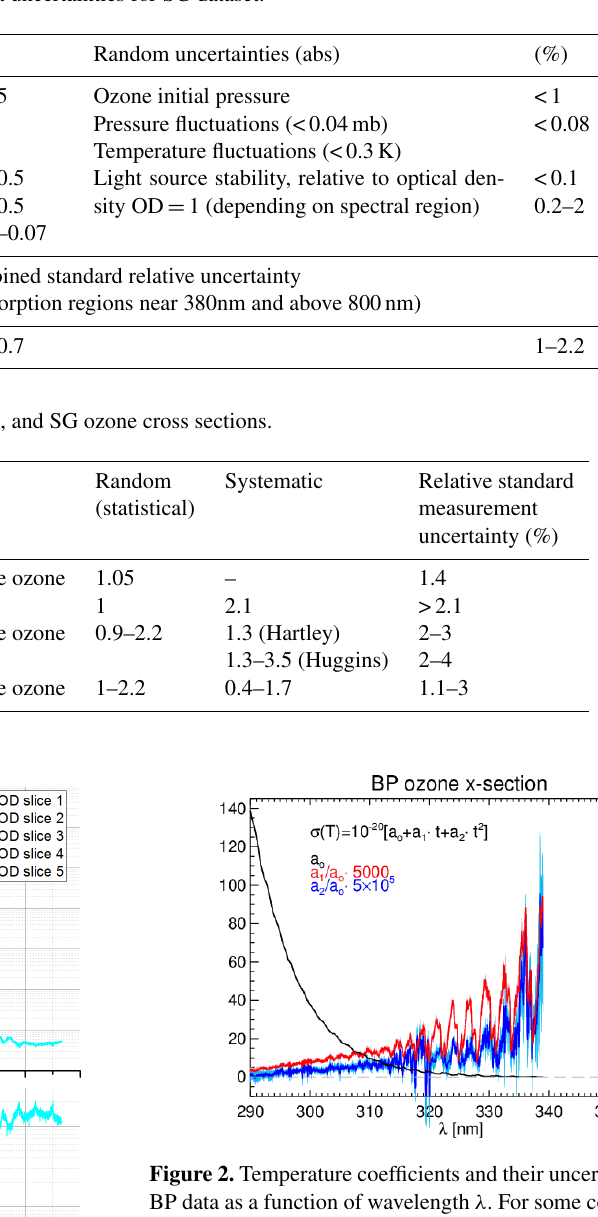
Table 5. Summary of absolute and relative measurement uncertainties for SG dataset.